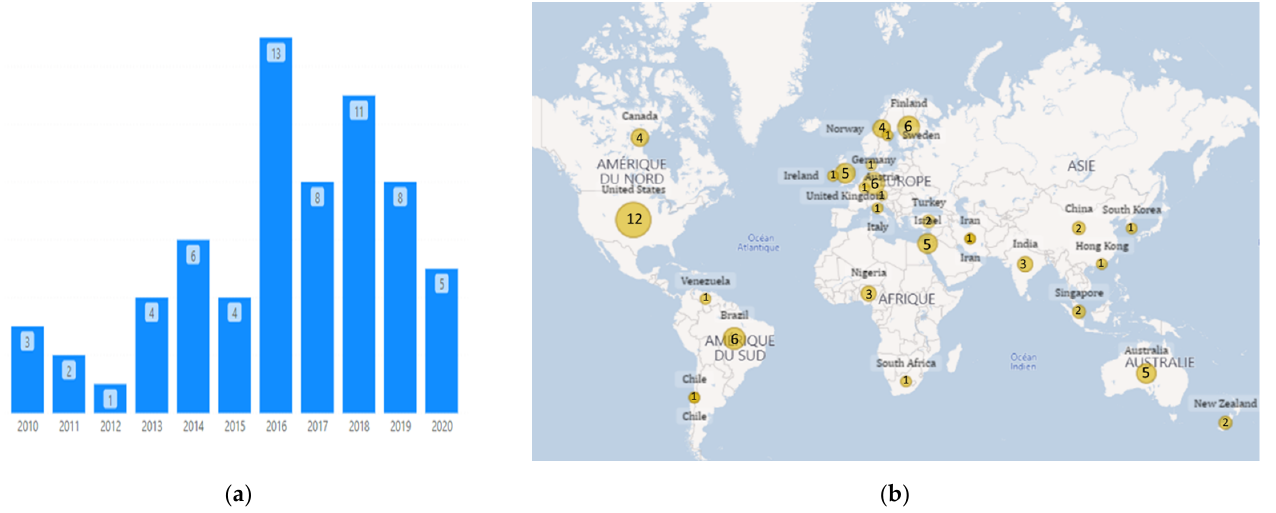
Figure 3. Distribution of number of publications addressing lean–BIM interaction at execution stage ( a ) per year and ( b ) per country from 2010 to 2020.